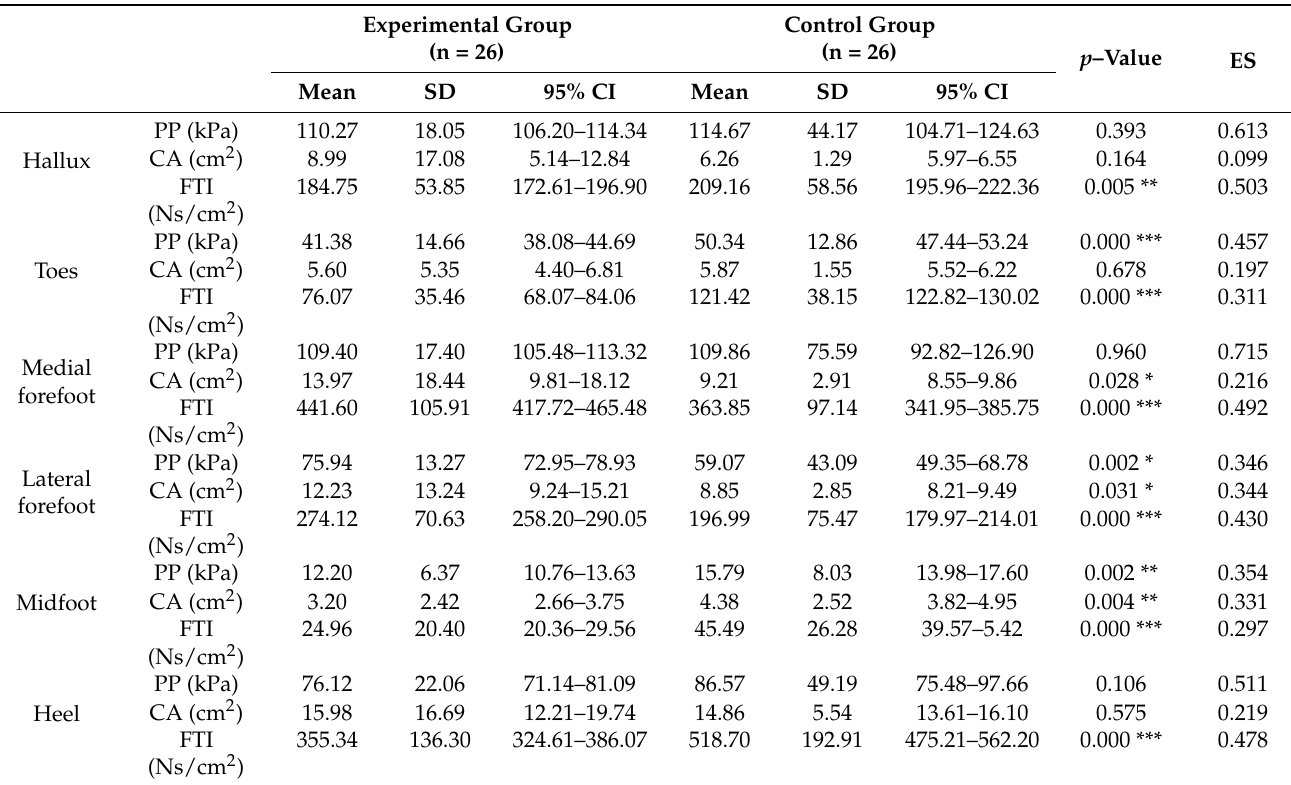
Table 3. Plantar foot pressure in high-heel shoes during walking.